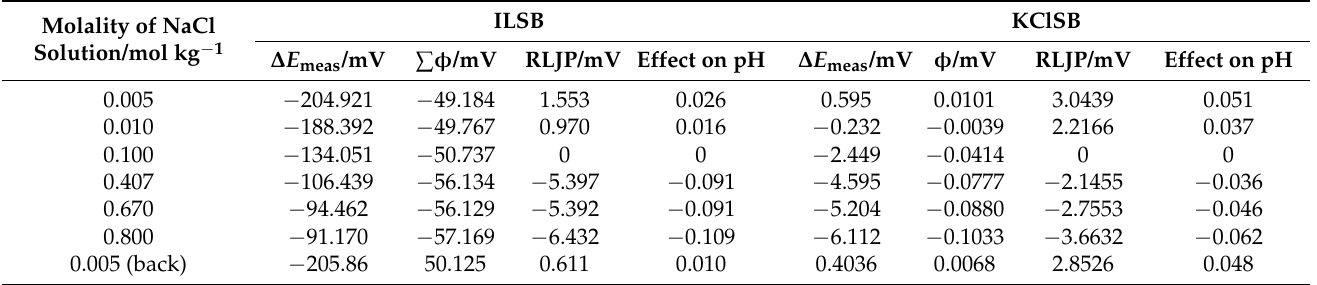
Table 5. Evaluation of RLJP based on measurements with NaCl solutions and DJ RE with salt bridge formed by IL and KCl. ∑ φ represents the sum of the two LJPs occurring at each end of the salt bridge. Molality of